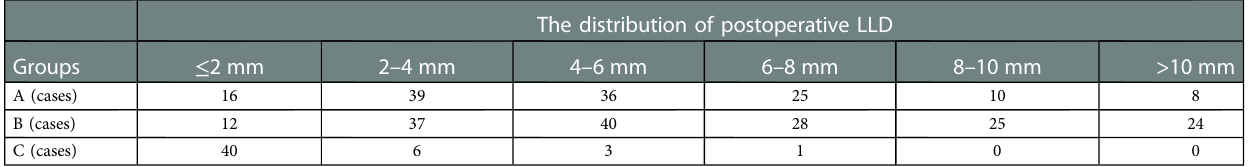
TABLE 2 The distribution of postoperative LLD in groups A, B, and